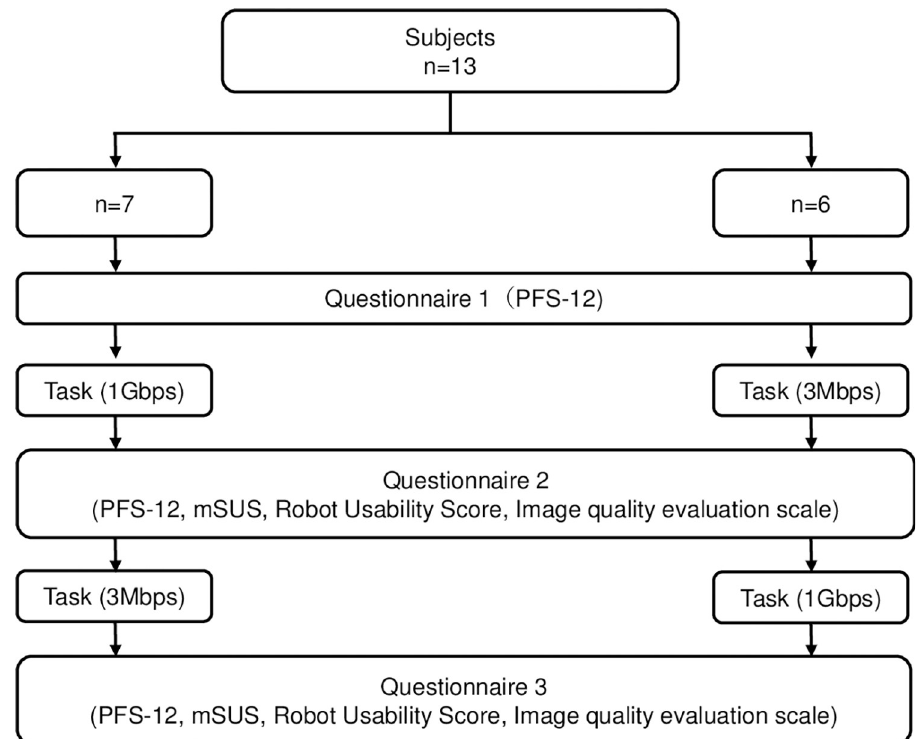
Fig 2. Flowchart of the order of the line speed and subjective evaluation of the task. The subjects were divided into two groups: Seven subjects performed the procedure in the sequence of 1-Gbps, then 3-Mbps, and the remaining six subjects performed the procedure in the order of 3-Mbps, then 1-Gbps. They answered questionaries pre- and post- procedure for each bandwidth.